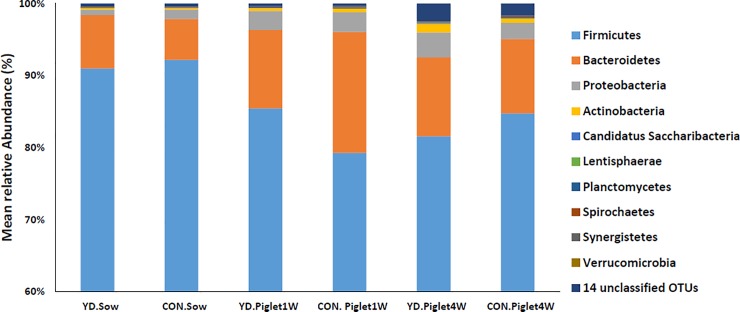
The distribution of bacterial phyla in fecal samples of sows and piglets of different ages fed different diets.